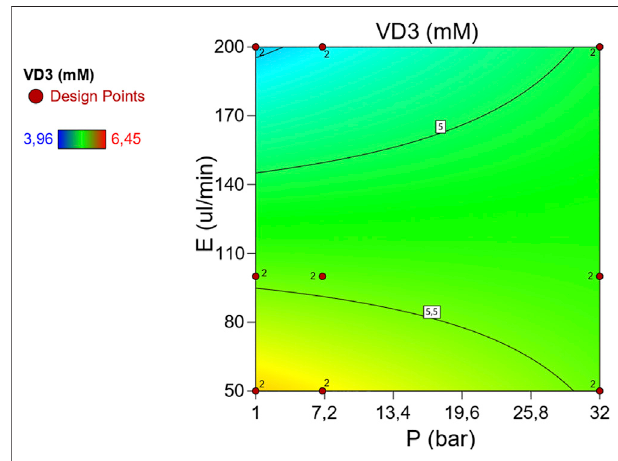
FIGURE 5 | Interaction plot of p , E effect in 7DHC measurements using high-p,T autosampler. ( Average points in green. In blue and in red the lower and the upper leveraged values respectively )